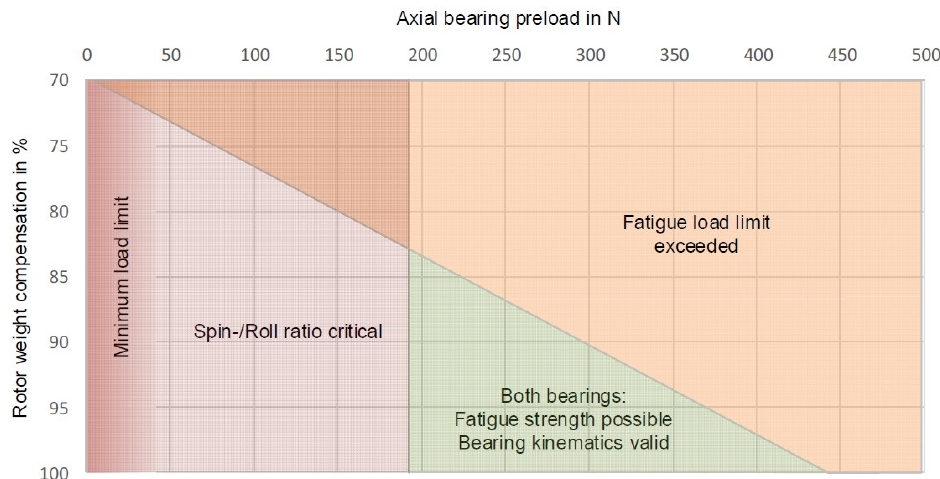
Figure 18. Rotor weight compensation and bearing preload for optimized bearing